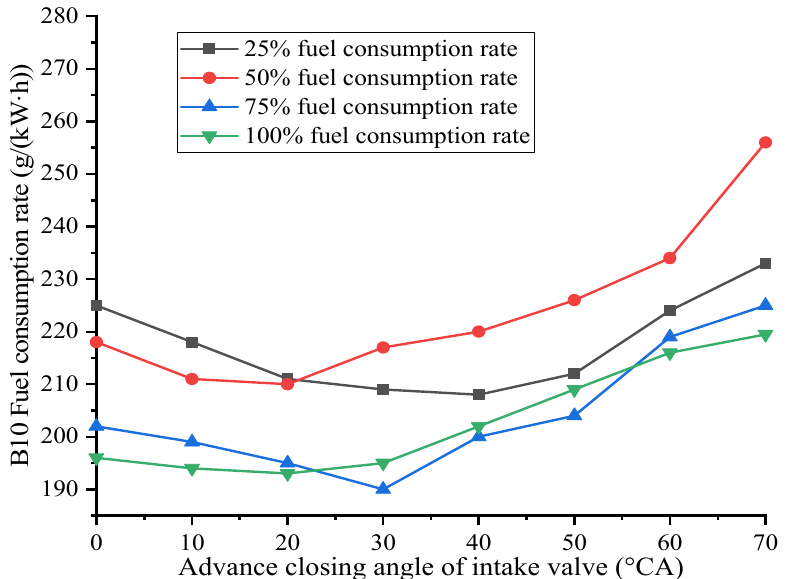
Figure 13. The effect of fuel consumption when Miller degree > 0 .